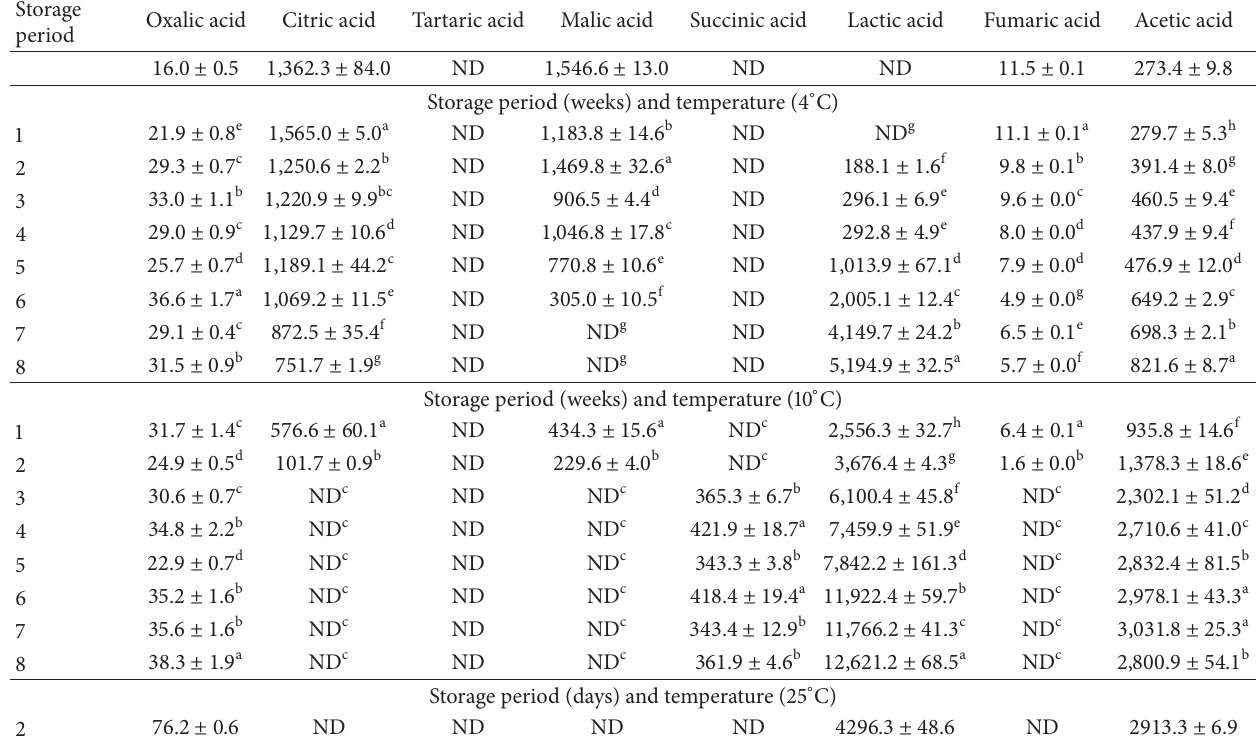
Table 4: Organic acids content (mg/kg) in kimchi samples stored at 4 and 10 ∘ C 1,2 .